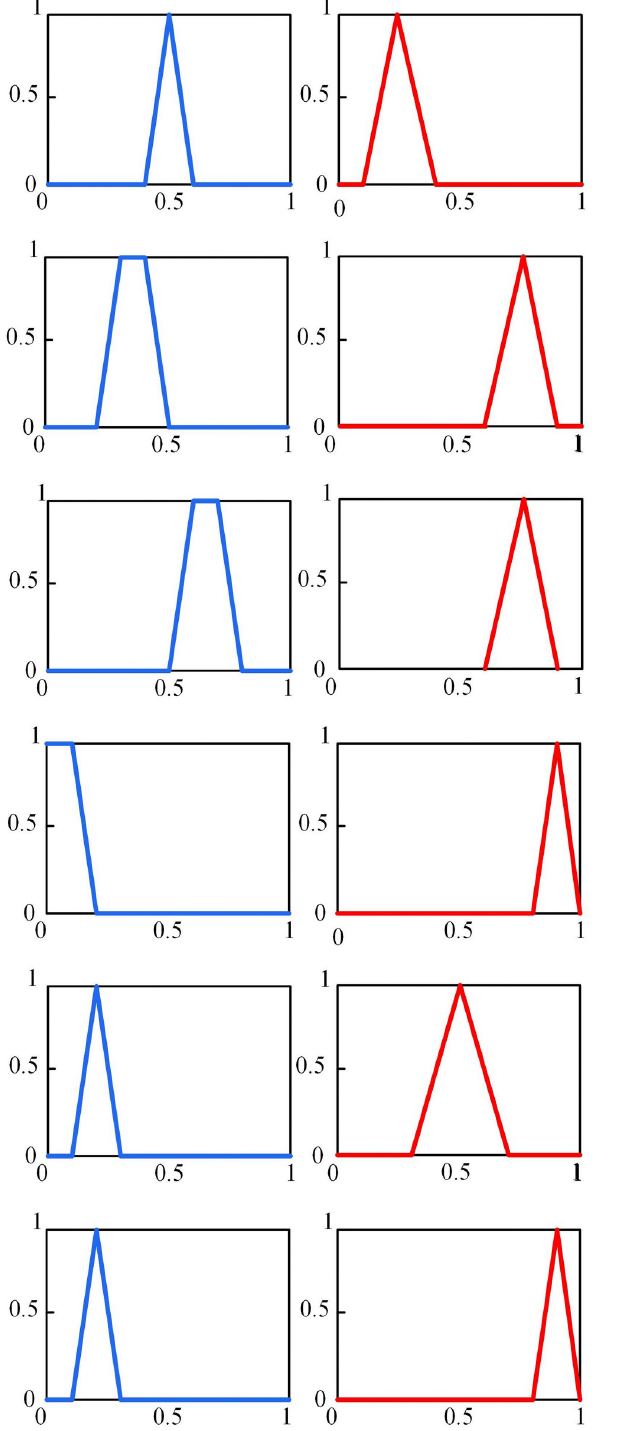
Fig 5. The Z-numbers related to APOA for EPC1 of subtask T1.